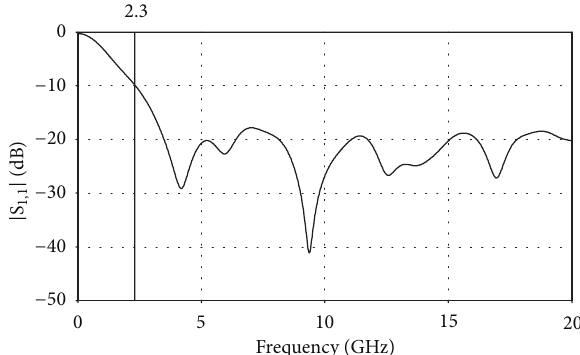
Figure 2: Simulated reflection coefficient magnitude of a conical antenna with circular aperture.